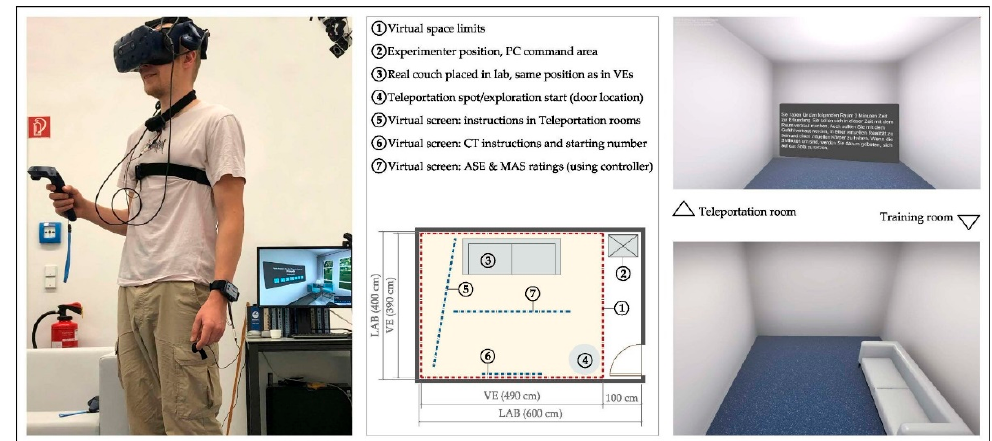
Figure 2. Virtual reality (VR) laboratory set up. Left side: VR setup in pilot session, participant about to start responding to rating scales. The physical couch is shown on the right side of the participant. Middle: general layout showing the virtual space in relation to the actual laboratory conditions, experimenter position, physical couch position, starting point of each exploration task, and virtual screens that appear successively during the paradigm. Top right: teleportation room, presented at the start of the VR session, and in between each of the rooms. Bottom right: training room, simulating the laboratory appearance.